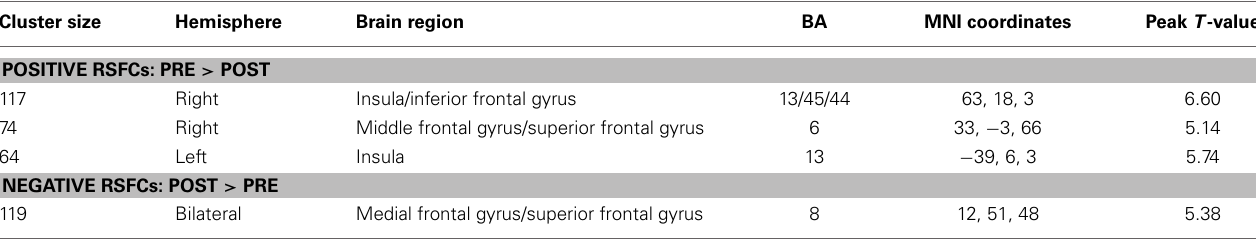
Table 3 | Significant changes in functional connectivities before and after HDT bed rest using the MCC as the seed region. Hemisphere Brain